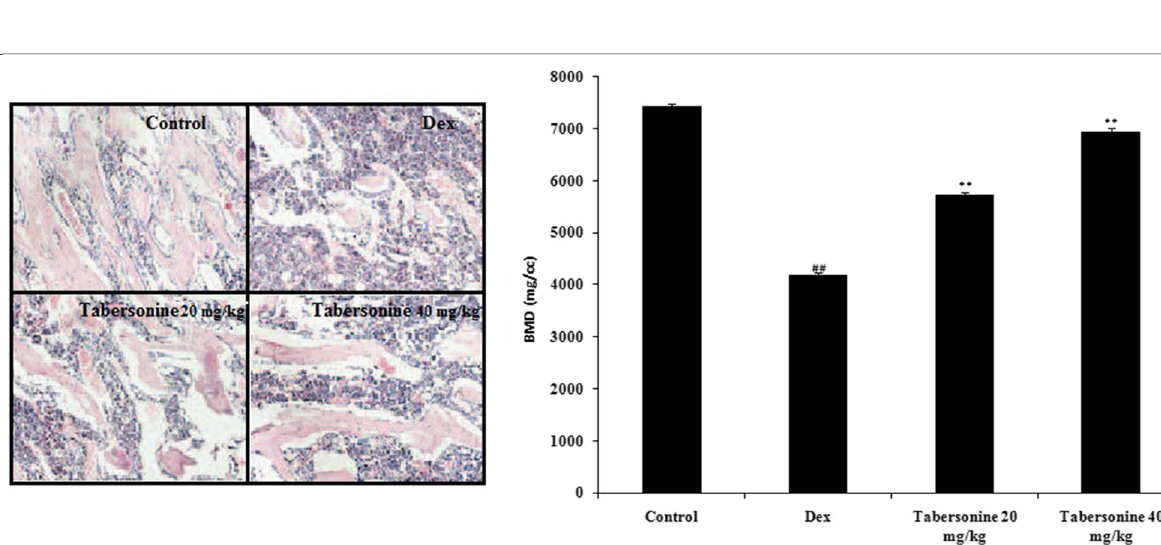
Fig. 9 Tabersonine ameliorated Dex-induced osteoporosis in rats. a Histopathological bone changes revealed by H&E staining (100 rats with Dex-induced osteoporosis treated or not treated with Tab.